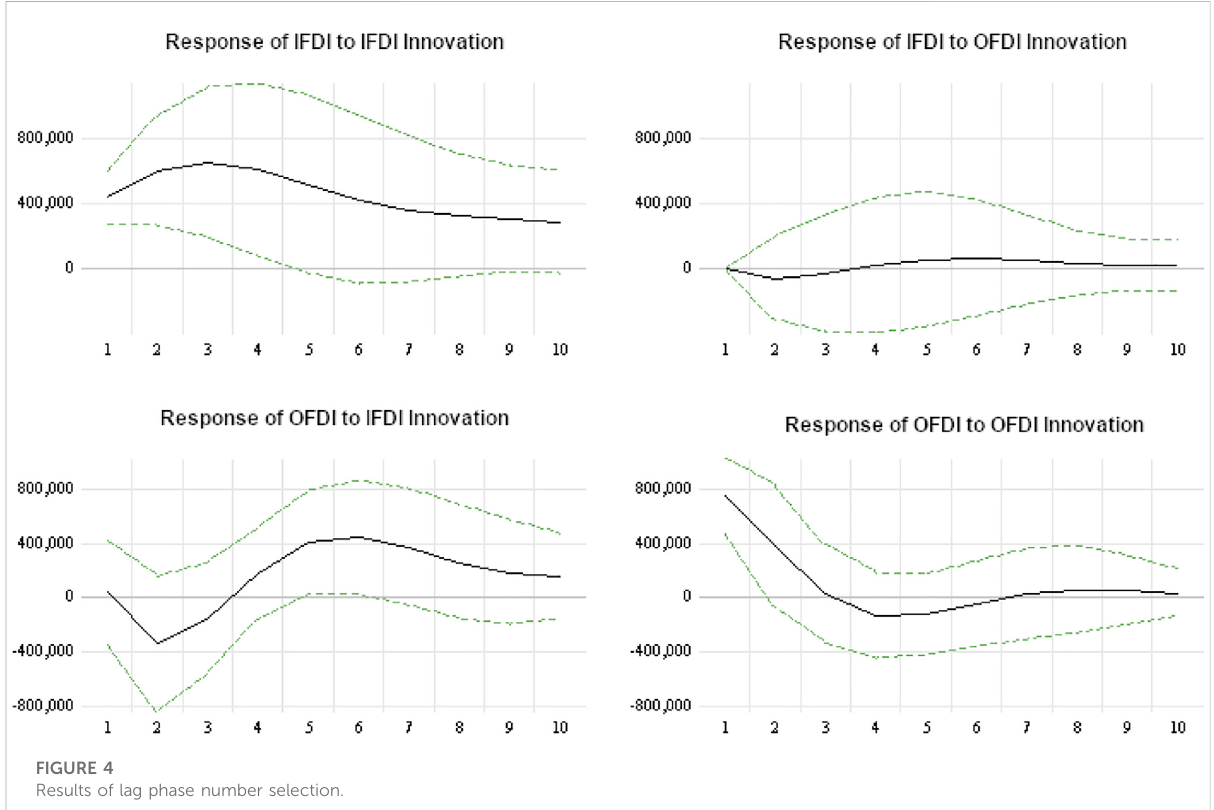
FIGURE 4 Results of lag phase number